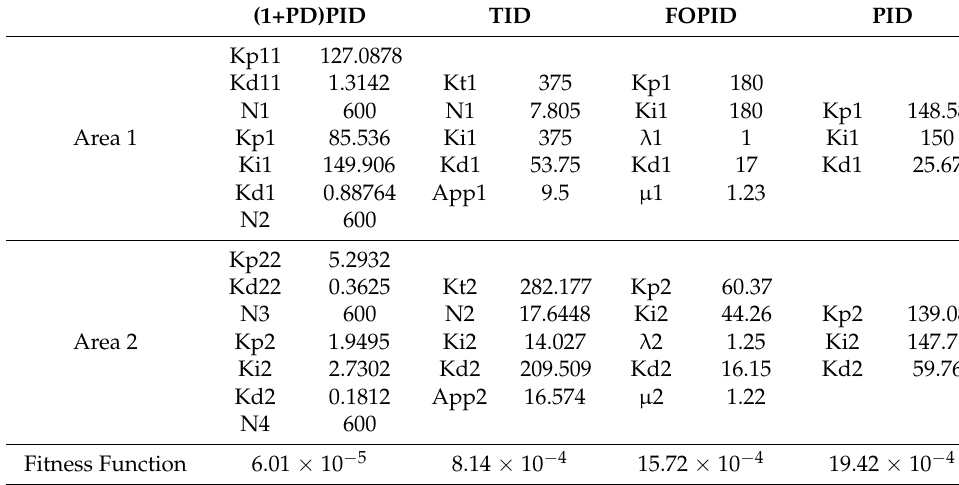
Table 2. Controller gains and fitness functions obtained by AVOA.